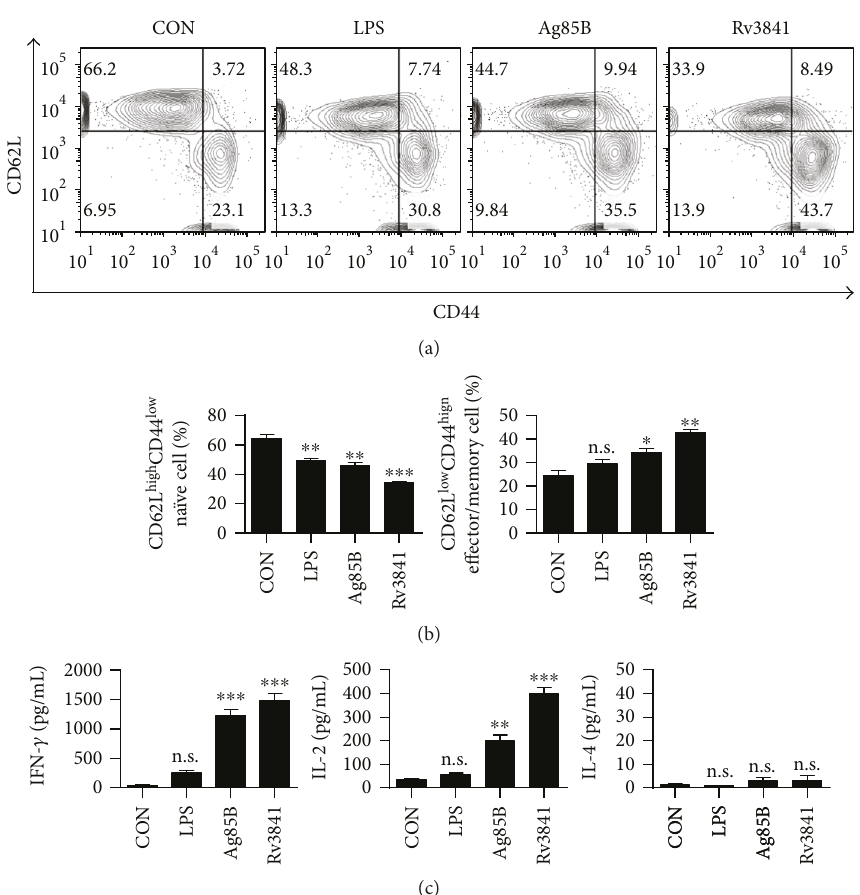
Figure 6: Rv3841-treated DCs induce expansion of the e ff ector/memory T-cell population. DCs from WT mice were treated with Rv3841 (10 μ g/mL) or LPS (100ng/mL) and then cocultured for 3 days with T-cells from Mtb-infected mice at the DC to T-cell ratio of 1: 10. Splenocytes were stained with anti-CD4, anti-CD62L, and anti-CD44 monoclonal antibodies. (a, b) A histogram is shown for gating of the labeled T-cells. Bar graphs show CD62L low CD44 high T-cells or CD62L high CD44 low T-cell populations among the spleen cells. (c) Culture supernatants were harvested after 96h, and IFN- γ , IL-2, and IL-4 concentrations were measured by ELISAs. The mean values ± SD ( n = 3 ) are shown; ∗ p < 0 05 , ∗∗ p < 0 01 or ∗∗∗ p < 0 001 : a signi fi cant di ff erence of treatment groups from the appropriate controls, as determined by one-way ANOVA test. Treatments without a signi fi cant e ff ect are indicated by “ n.s. ”